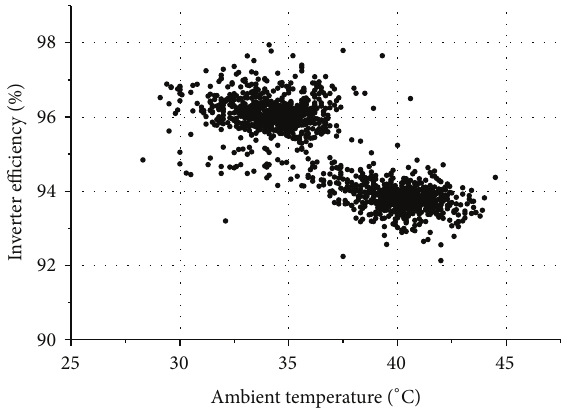
Figure 4: Relation between inverter efficiency and ambient temper- ature.